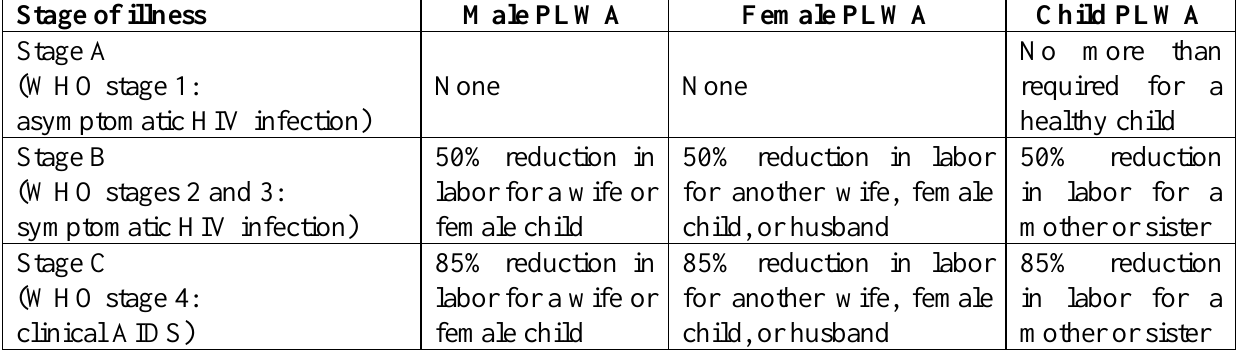
Table 1. Estimated reductions in labor contributions by caregivers of